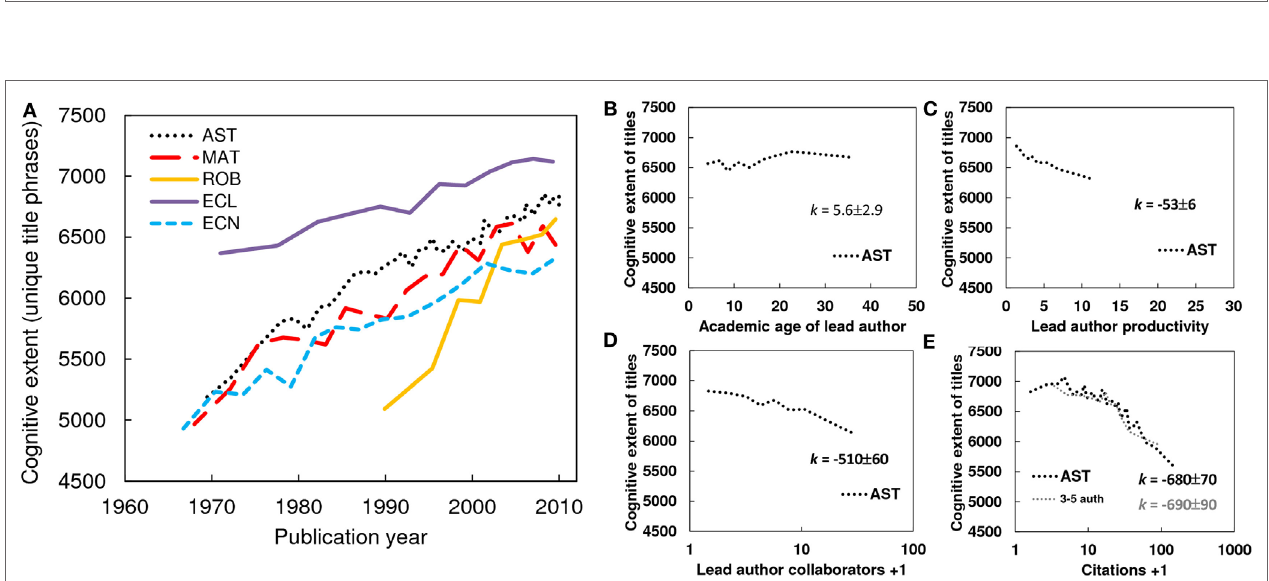
FigUre 5 | Trends involving cognitive extent (number of unique title phrases) . (a) Cognitive extent for five disciplines [astronomy (AST), mathematics (MAT), robotics (ROB), ecology (ECL), and economics (ECN)] from 1961 to 2010. Cognitive extent for authors of different academic age (b) , productivity (c) , collaboration level (D) , and papers of different impact level (e) .